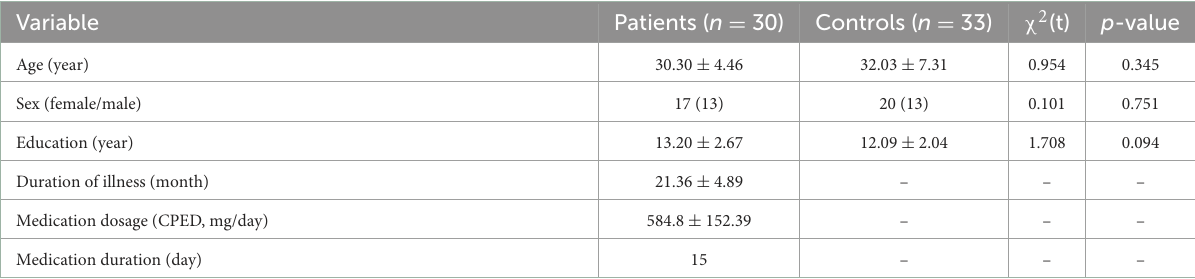
TABLE 1 Demographic and clinical characteristics of the